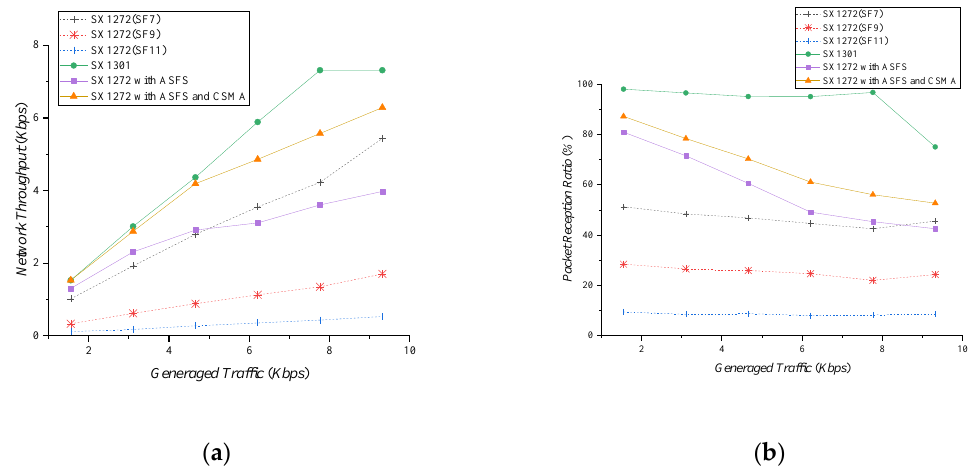
Figure 7. Network throughput and packet reception ratio with respect to network traffic volume: ( a ) Network Throughput; ( b ) Packet Reception Ratio.